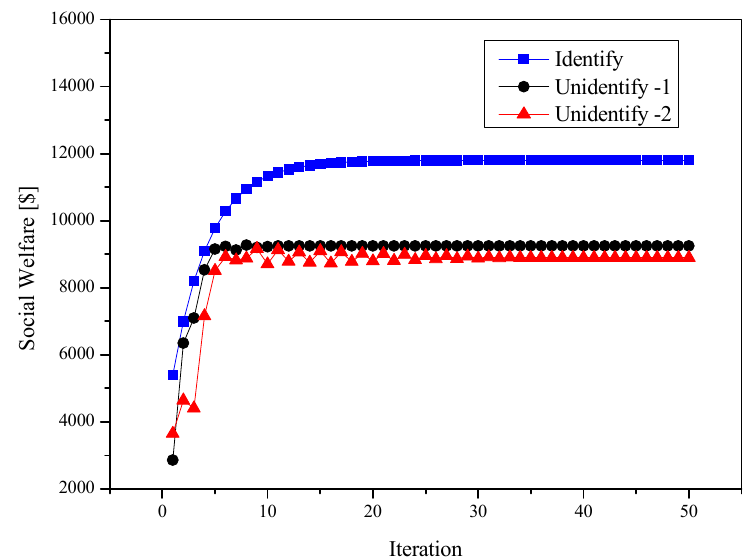
Figure 9. Comparison of social welfare with Identify case and Unidentified cases .